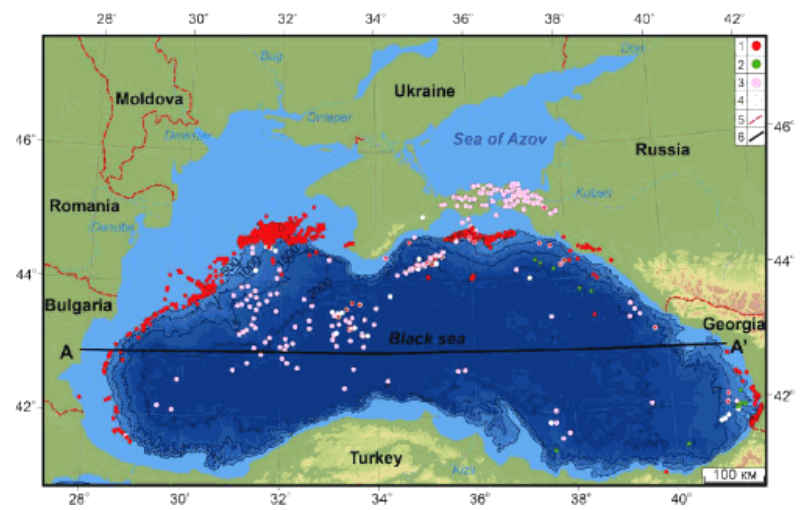
Figure 4 . Seafloor degassing in the Black and Azov seas. 1: gas seep locations; 2: oil seep locations; 3: submarine mud volcanoes; 4: gas hydrates; 5: state borders; 6: location of the section of suitable temperature and water salinity [105]